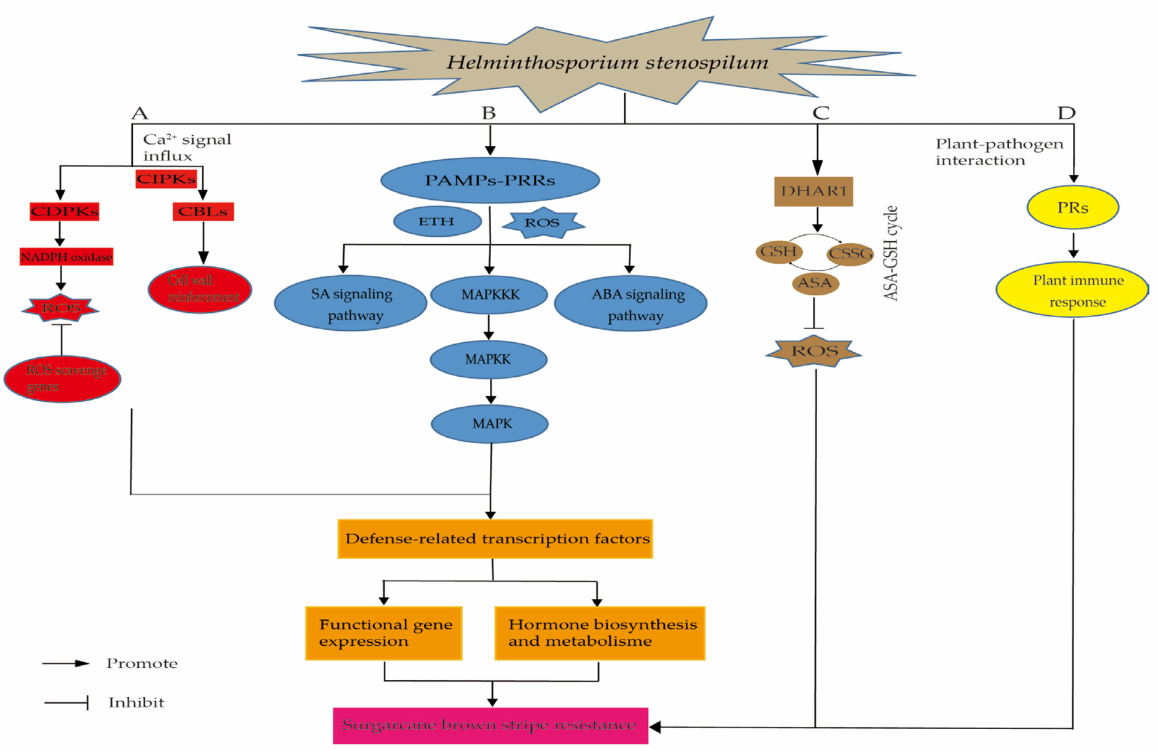
Figure 7. A potential molecular mechanism of sugarcane and H. stensopilum interaction. A, Ca 2+ sig- naling pathway; B, MAPKs cascade signaling pathway; C, ASA-GSH cycle; D, plant immune